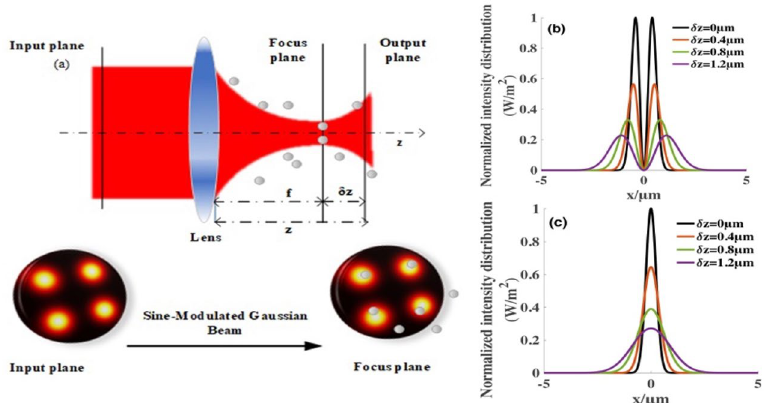
Figure 1. An illustration of the focusing optical system. ( a ) shows the schematic of the SMGBs, where z is the longitudinal coordinate at the beginning of the focusing lens, z = f + δ z . δ z is the distance from the focal point on the axis, and f is the focal length of the thin lens. ( b,c ) demonstrate the normalized intensity distribution of SMGBs and Gaussian beams at different distance values of δ z , respectively. Other parameters are (cid:31) = 1.064 µ m , w 0 = 5 mm , f = 5 mm , P = 4 w and the sine-modulation coefficient g = 1